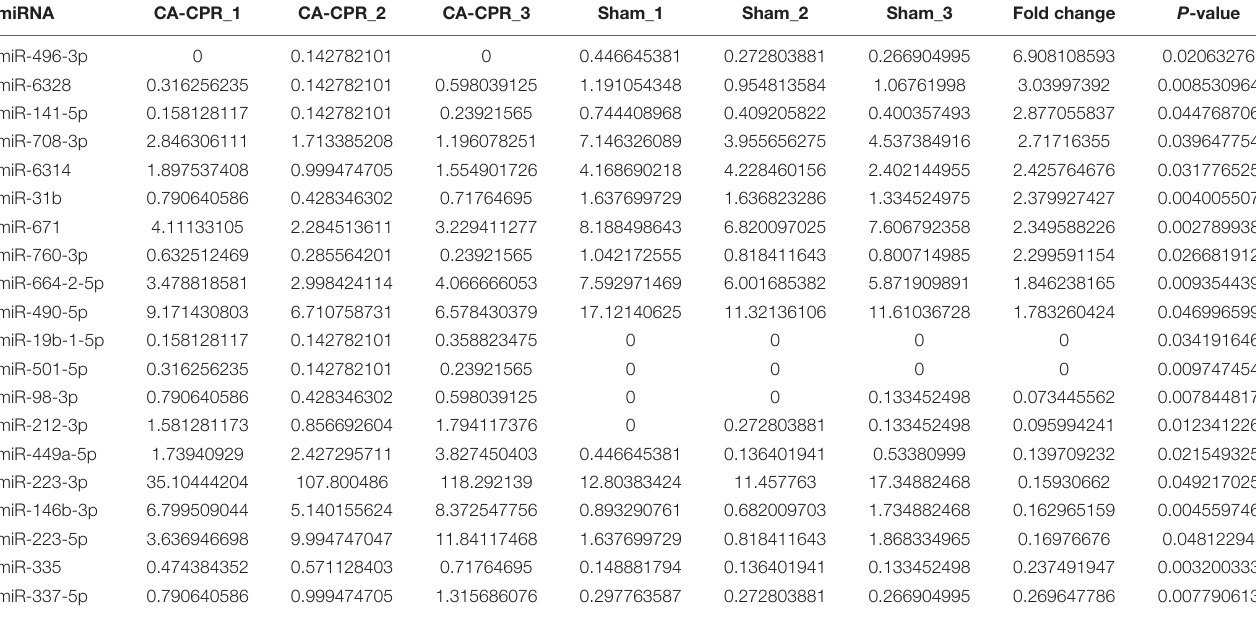
TABLE 3 | The top 20 differentially expressed miRNAs detected by high-throughput sequencing analysis.